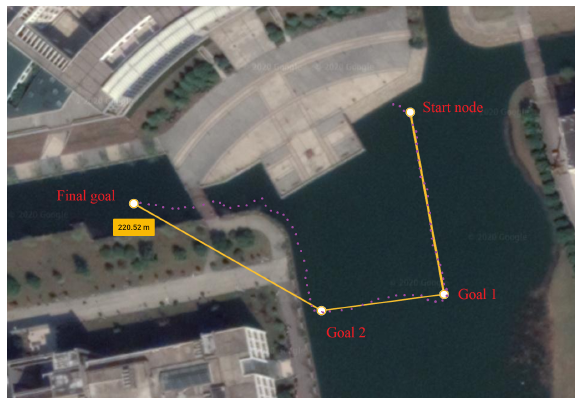
Figure 22. Planned and actual path.